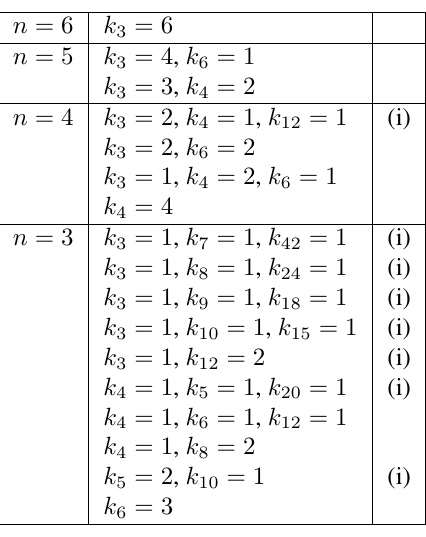
Tab. 1: Possible combinatorial types of vertex coronae following from Lemma 2.4. Cases that are impos- sible for further reasons are marked with